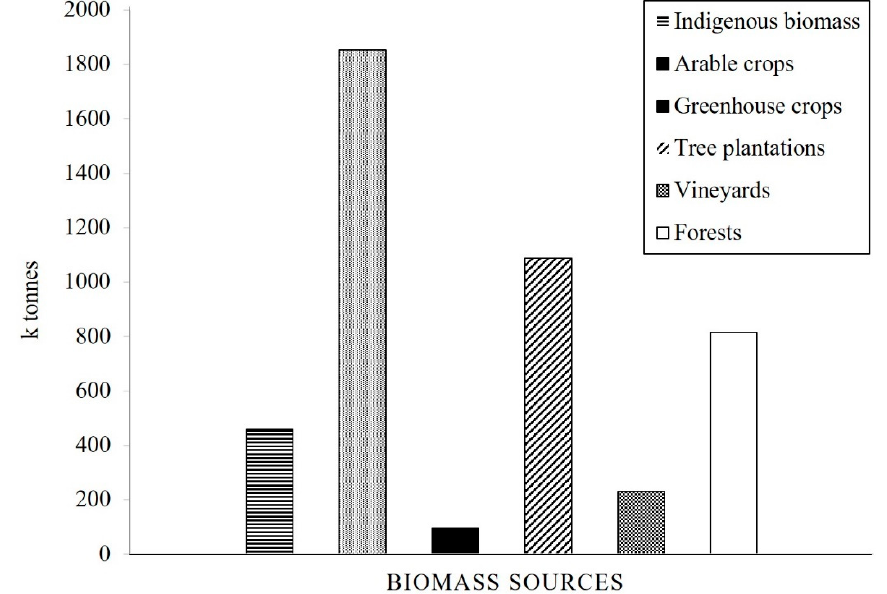
Figure 4. Annual quantities of biomass per source in Greece [16].